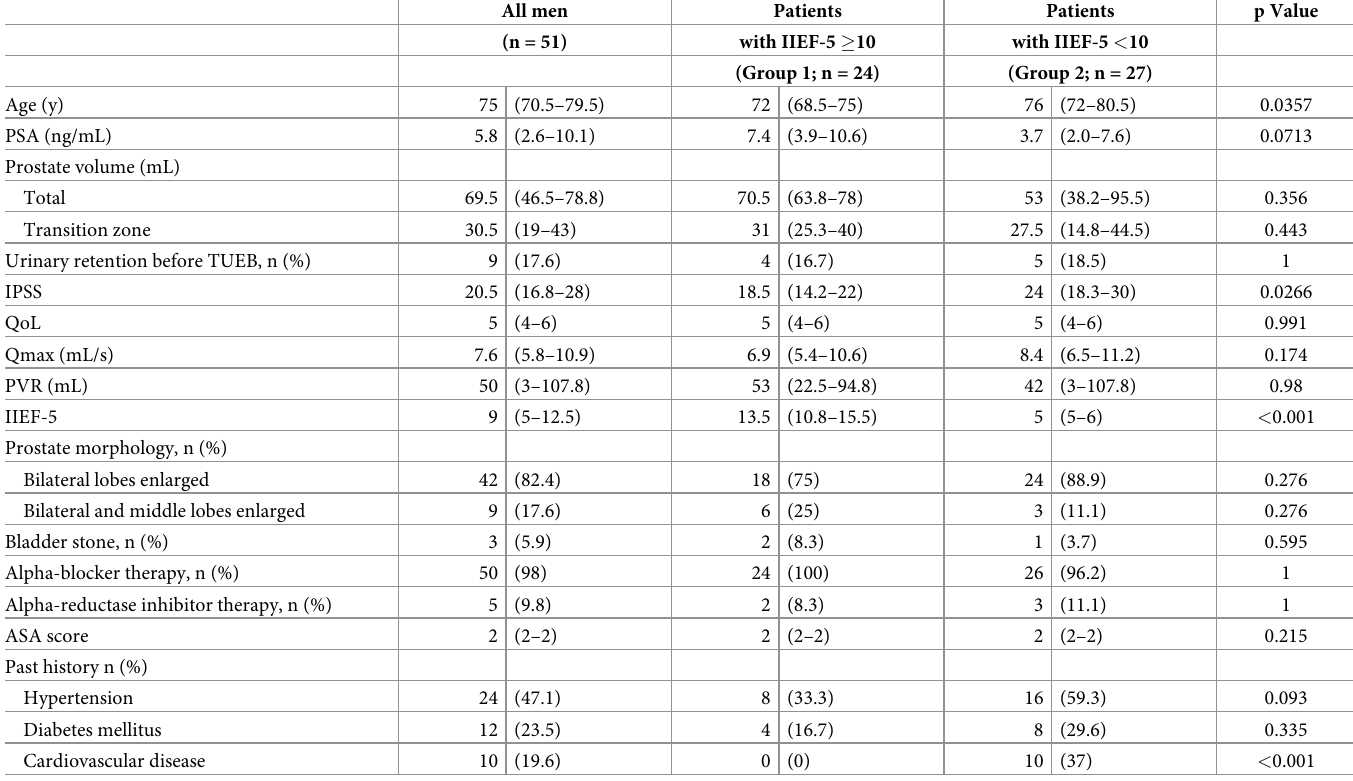
Table 1. Patient characteristics.